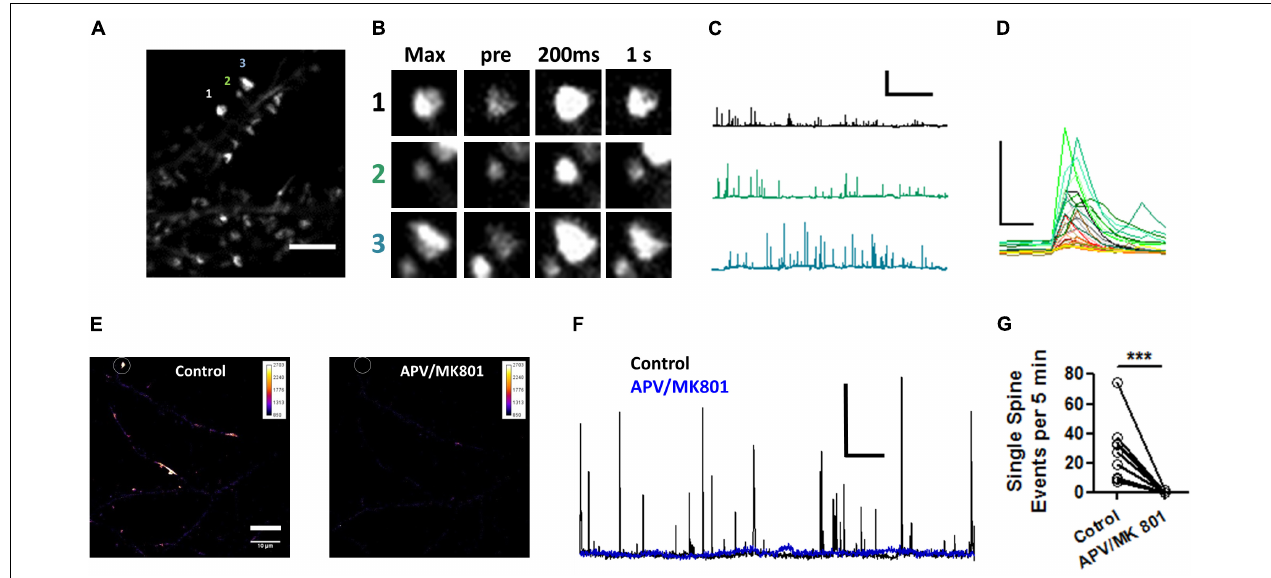
FIGURE 6 | Visualization of NMDAR-mediated GCaMP6S Ca 2 + signals in single spines. (A) Maximum projection of 200 s recordings at low laser intensities. Scale bar: 5 µ m. (B) Regions of interest shown on (A) . Max projection zooms for regions 1–3. pre indicates the time point (–200 ms) immediately precedent an event, 200 ms first time point in the event series, and 1 s spine signal 1 s after the peak response. (C) Three one 500 s long traces showing the transient increases in fluorescence plotted as (cid:49) F/F for the spines indicated in (A) . (D) Selected zoomed events from those shown on (C) , only 3 s are shown. Scale bar 5X (cid:49) F/F